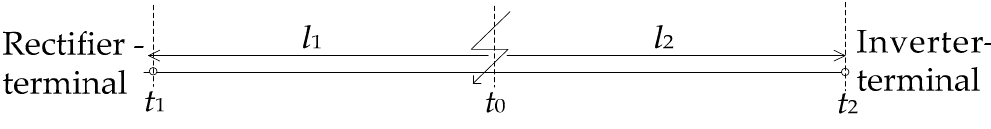
Figure 1. The magnitude of the frequency components of a signal extracted by the S transform.